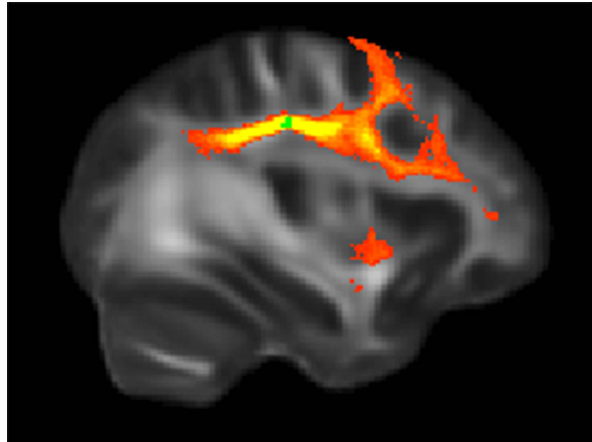
Figure 6. Group probability map generated from the orienting- related regions. The red-yellow region was identified as superior longitudinal fasciculus (SLF). The green cluster was the seed mask located in the right